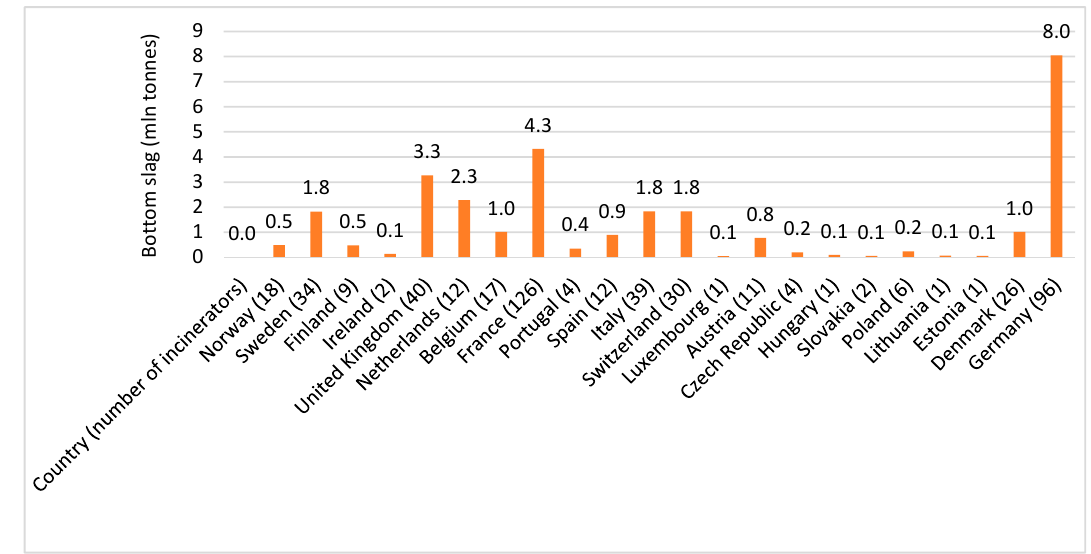
Figure 1. The number of incinerator plants and amount of bottom ash produced in Europe in 2017 [1].